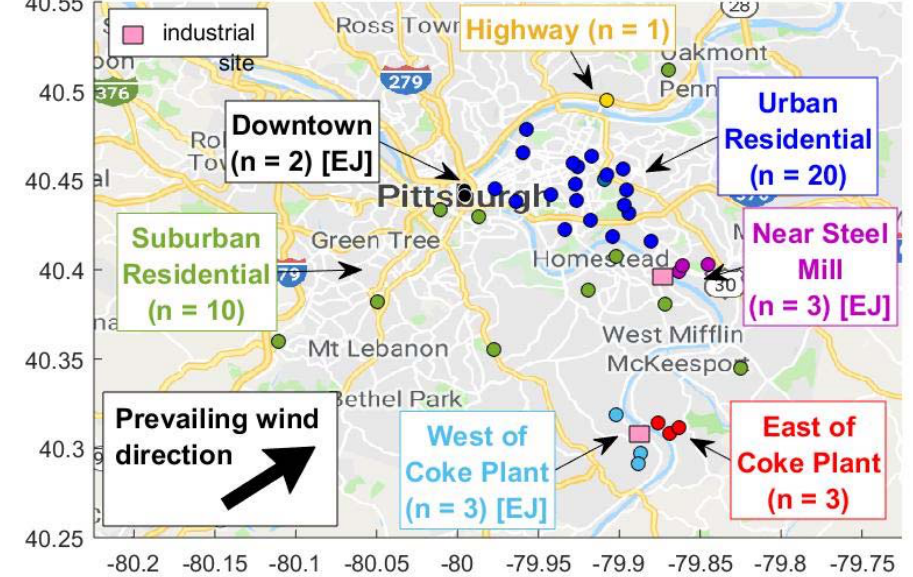
Figure 1. Map of the sampling domain. Dots indicate locations of 42 Real-time Affordable Multi-Pollutant sensor package (RAMP) monitors that were deployed throughout Pittsburgh. The sites were categorized into 2 Downtown sites, 20 Urban Residential sites, 10 Suburban Residential sites, 1 Near Highway site, 3 Near Steel Mill sites, 3 sites West of a Coke Plant, and 3 sites East of a Coke Plant based on traffic density, restaurant density, and proximity to industrial point sources (shown as pink squares). The prevailing wind direction is also shown; a wind rose is displayed in the Supplementary Information.